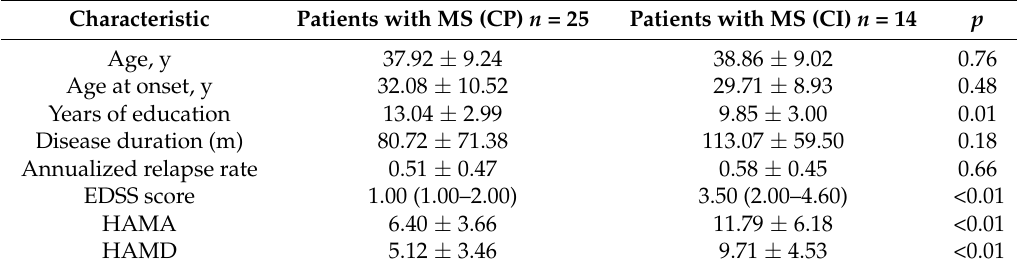
Table 6. Demographic and clinical characteristics of the MS patients with CI and CP. Characteristic Patients with MS (CP) n = 25